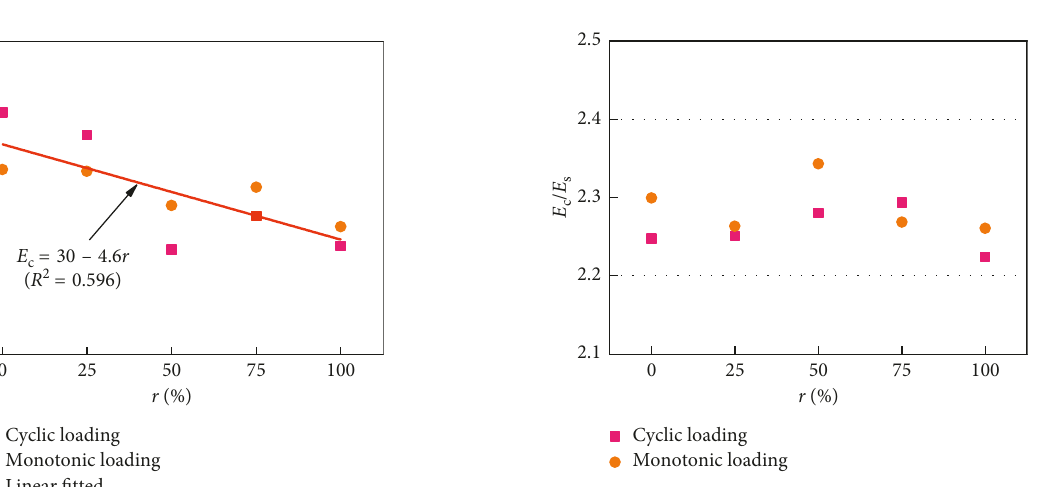
ε corresponding to (a) equation (5a) and (b) equation (5b).